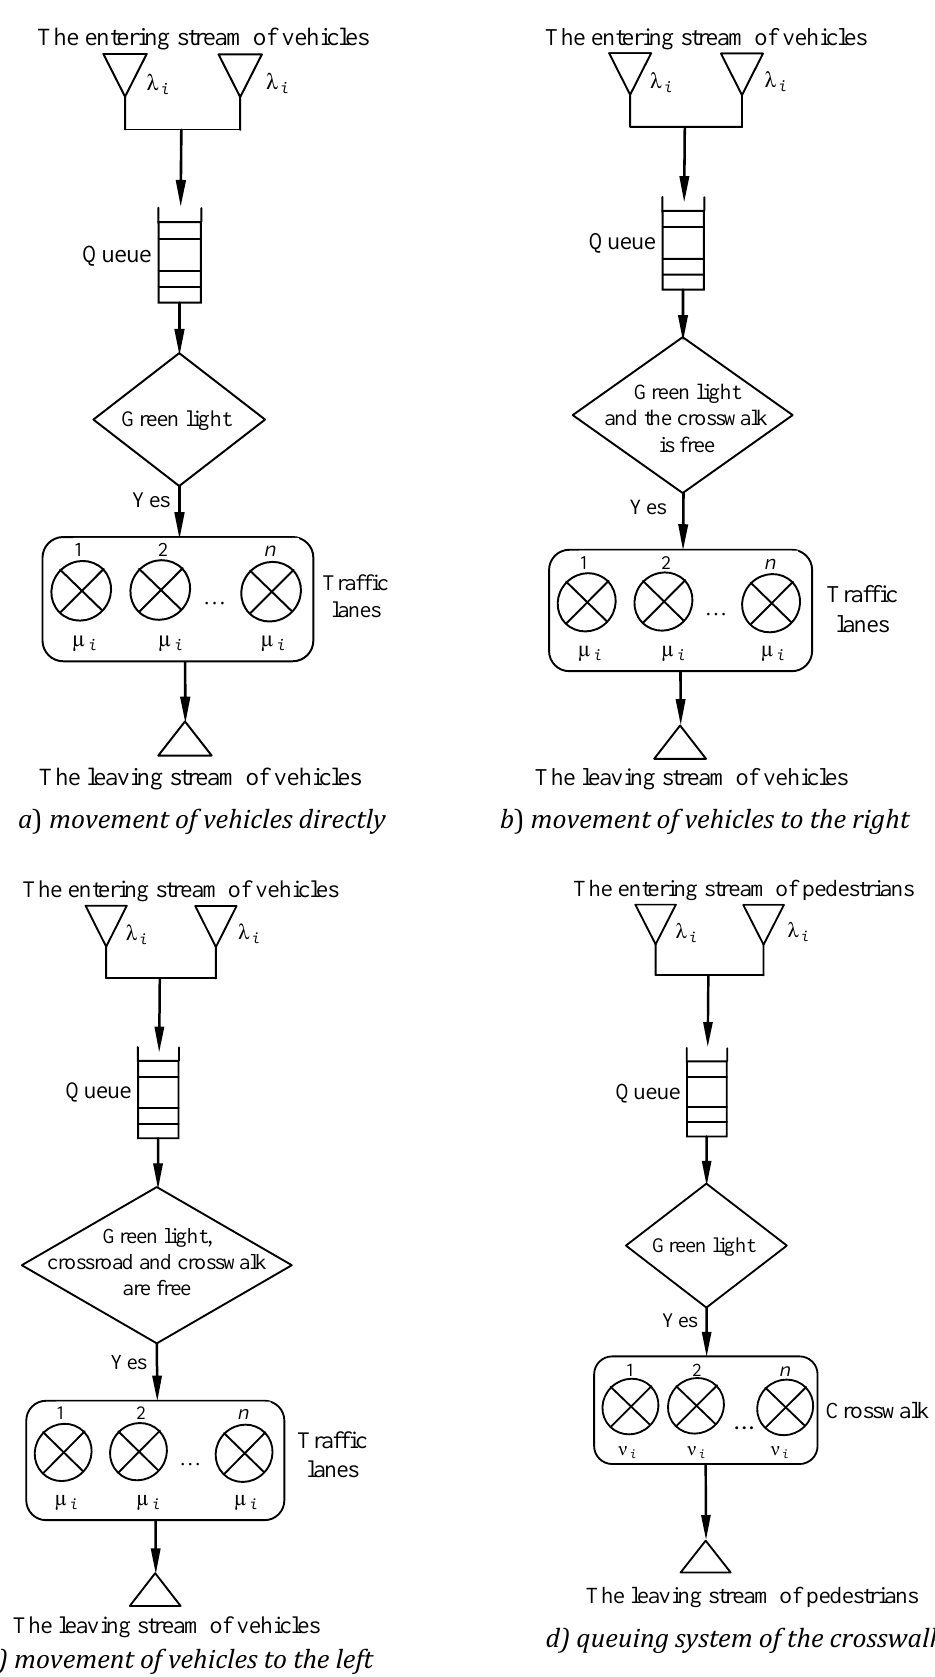
Figure 1: Queuing systems of adjustable